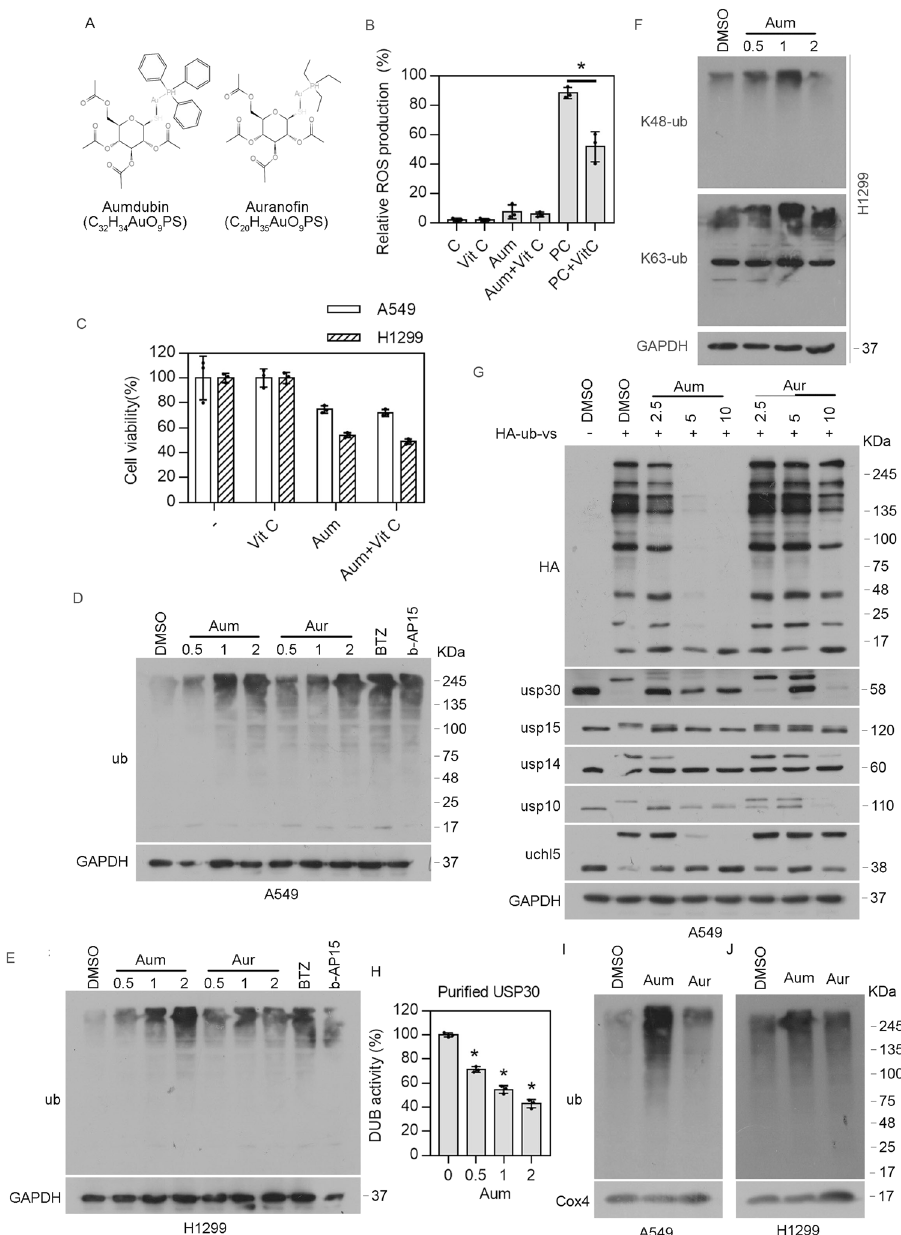
Fig. 1 Aumdubin inhibits USP30 stronger than aurano fi n in A549 and H1299 cells. A Chemical structure of aumdubin and aurano fi n. B Aumdubin did not induce the production of ROS. H1299 cells were exposed to aumdubin (1 µM) or positive control ROSup (PC) in the absence or presence of antioxidant vitamin C (Vit C, 100 µM) for 1 h, ROS was detected with DCF-DA staining by fl ow cytometry. C: control. Mean ± s.d. (n = 3). * P < 0.05. C Cytotoxic effects of aumdubin may be not dependent on ROS production. A549 and H1299 cells were exposed to aumdubin (1 µM) in the absence or presence of antioxidant vitamin C (Vit C, 100 µM) for 24 h, and then were subjected to MTS assay. Mean ± s.d. ( n = 3). D , E Accumulation of ubiquitinated proteins by aumdubin. A549 ( D ) and H1299 ( E ) cells were treated with various concentrations of aumdubin (Aum) and aurano fi n (Aur) for 6 h, and then total ubiquitinated proteins were detected with western blotting assay. Bortezomib (BTZ, 100 nM) and b-AP15 (0.5 μ M) were used as positive controls. GAPDH were used as a loading control. F Accumulation of K48- and K63- linked ubiquitinated proteins by aumdubin. H1299 cells were treated with various concentrations of aumdubin (Aum) for 6 h, and then K48- and K63-linked ubiquitination were detected with western blotting assay. GAPDH were used as a loading control. G Aumdubin inhibits DUBs. A549 cells were treated with the indicated concentrations of aumdubin and aurano fi n for 3 h, and then whole-cell lysates were labeled with HA-ub-vs and immunoblots with the indicated antibodies. H Aumdubin inhibits USP30. The puri fi ed recombinant USP30 was treated with the indicated concentration of aumdubin for 6 h, followed by detecting DUB activity with Ub-AMC reagent. I , J Aumdubin induces ubiquitination of mitochondrial proteins. A549 ( I ) and H1299 ( J ) cells were treated with the indicated concentrations of aumdubin and aurano fi n for 6 h, and then mitochondrial proteins were isolated using mitochondrial protein extraction kit. Ubiquitinated proteins were detected with western blotting assay. COX4 were used as a loading control.